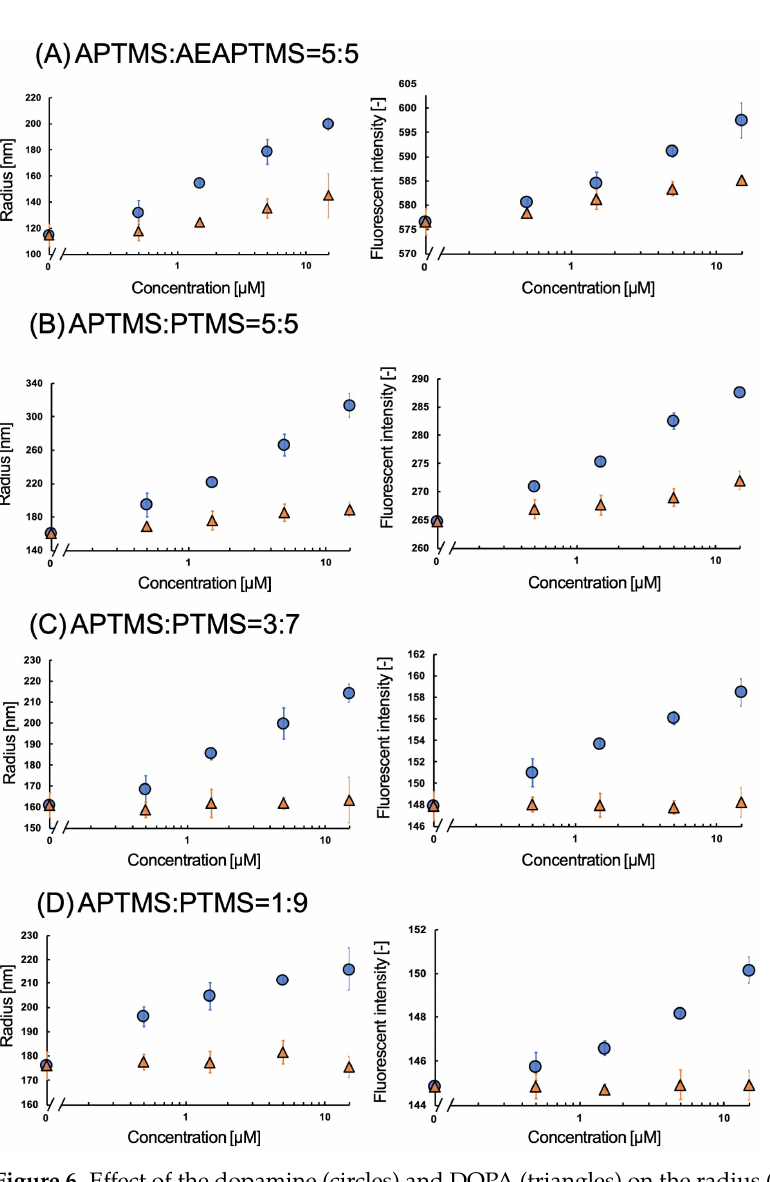
Figure 6. Effect of the dopamine (circles) and DOPA (triangles) on the radius ( left ) and fluorescent intensity ( right ) of the fMIP-NP synthesized with the 5-HT as a template anchored with a mixture of ( A ) APTMS and AEAPTMS (1:1 in mole) or PTTMS and PTMS, ( B ) 5:5, ( C ) 3:7, and ( D ) 1:9 in mole.